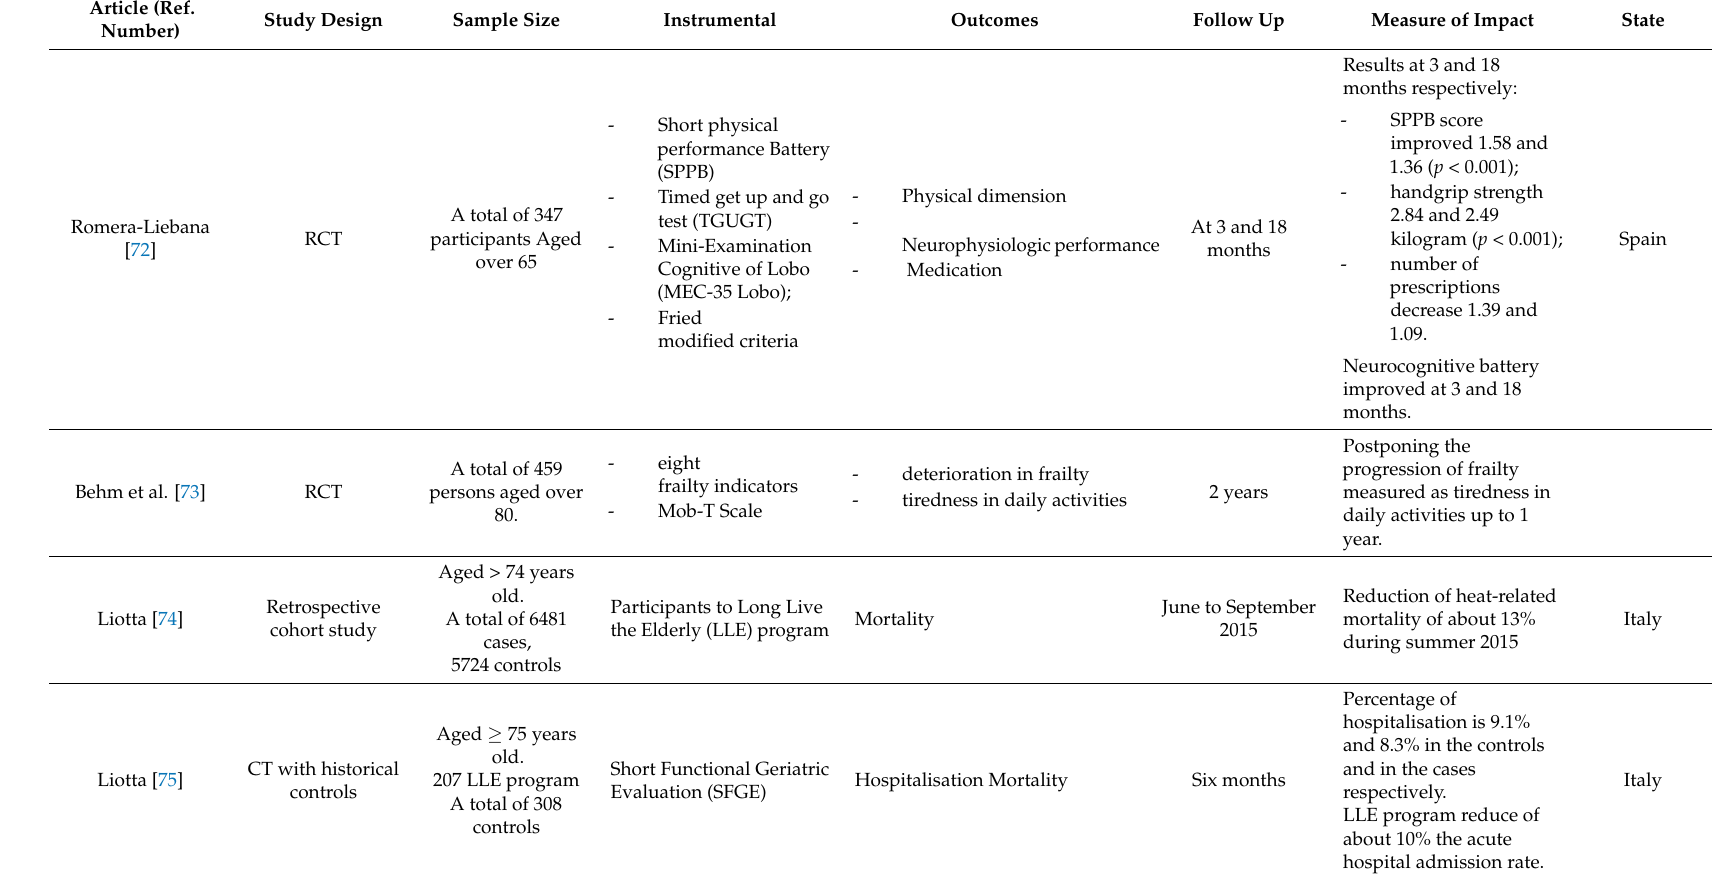
Table 4. Papers on impact evaluation of program addressing frailty in older